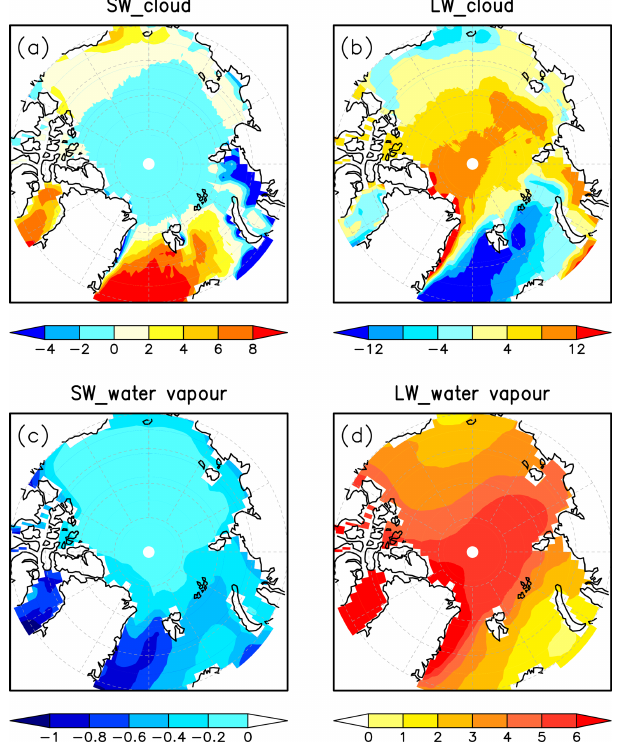
Figure 7. Spatial distributions of the Pliocene annual mean radia- tion fluxes change (Wm − 2 , positive downward) with respect to the pre-industrial period over the Arctic Ocean. (a) Shortwave radiation due to cloud change; (b) longwave radiation due to cloud change; (c) shortwave radiation due to water vapour change; (d) longwave radiation due to water vapour change. Here, cloud and water vapour change is the value before removing the remote effects of clouds and water